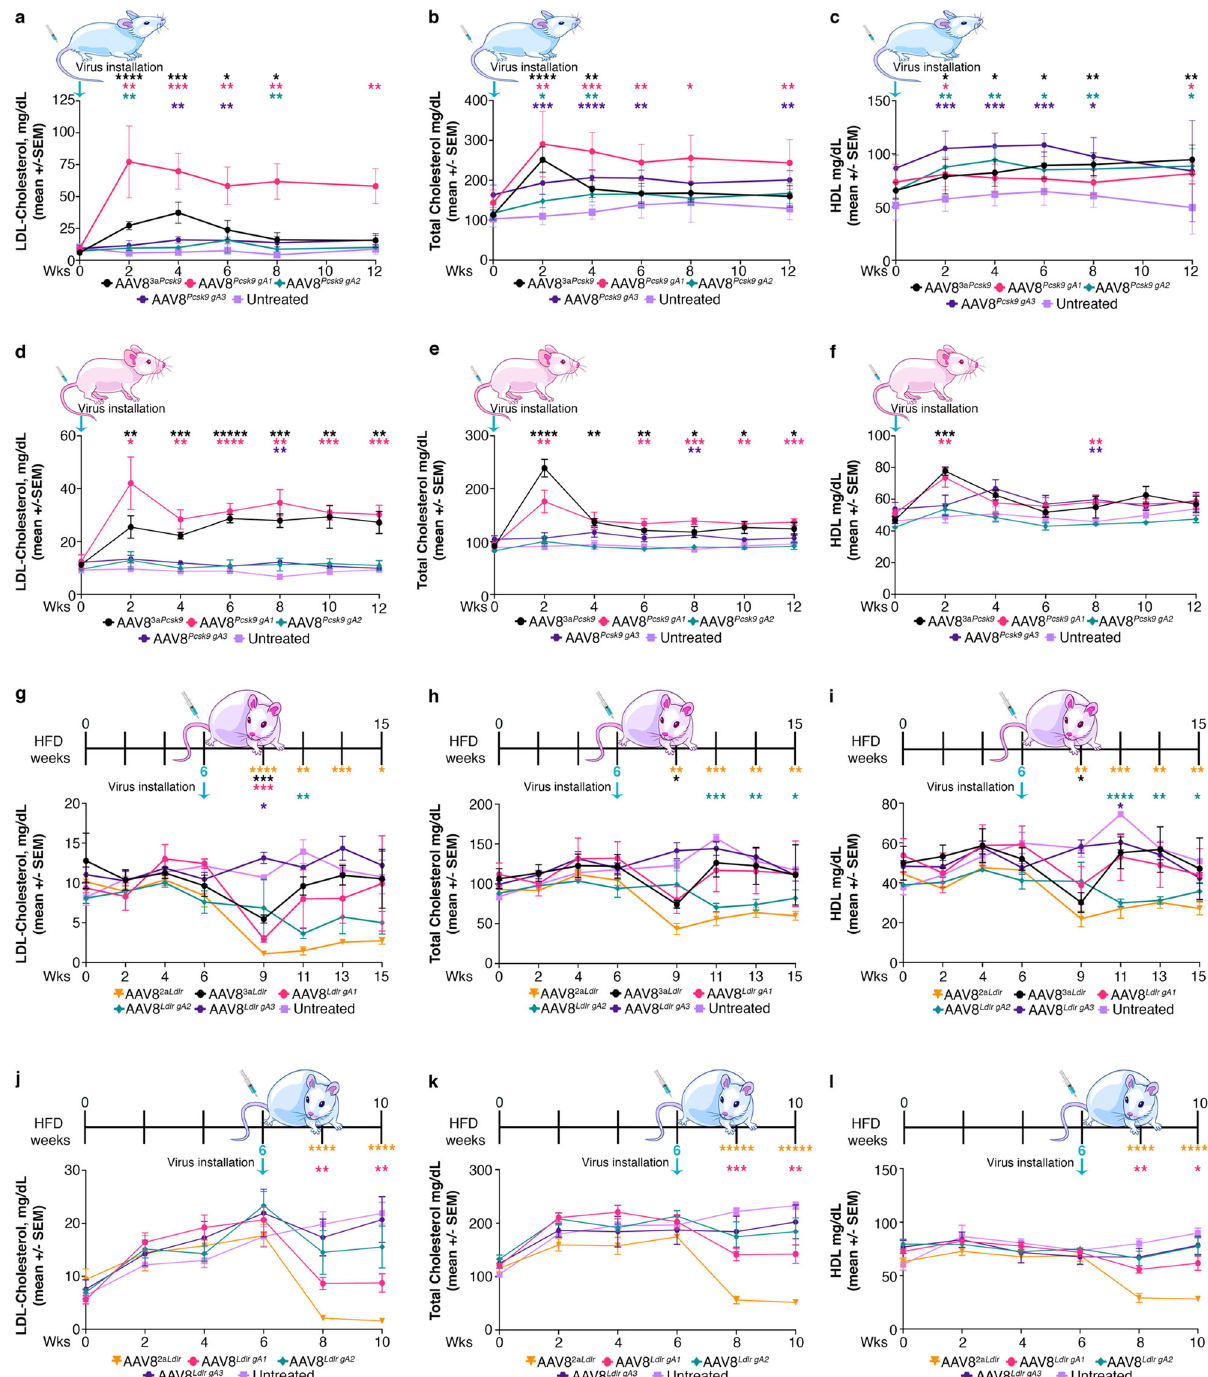
Fig. 5 Bi-directional modulation of lipid metabolism. a – c Pcsk9 activating guides were introduced by AAV8 to male R26 SAM / SAM mice after a baseline bleed ( n = 5) with bi-weekly bleeds taken thereafter for serum chemistry. Weekly p -values can be found in Supplementary Table 5. a LDL-cholesterol, b total cholesterol, and c HDL-cholesterol levels were plotted as mean + / − SEM per group. d – e Pcsk9 activating guides were introduced by AAV8 to female R26 SAM / SAM mice after a baseline bleed ( n = 5) with bi-weekly bleeds taken thereafter for serum chemistry. Weekly p -values can be found in Supplementary Table 5. d LDL-cholesterol, e total cholesterol, and f HDL-cholesterol levels were plotted as mean + / − SEM per group. g – i Homozygous female R26 SAM study mice were placed on a HFD for six weeks prior to AAV8 Ldlr activating viruses were introduced ( n = 4). Weekly p -values can be found in Supplementary Table 5. g LDL-cholesterol, h total cholesterol, and HDL-cholesterol levels were plotted as mean + / − SEM per group. (j-l) Homozygous male R26 SAM study mice were placed on a HFD for 6 weeks prior to AAV8 Ldlr activating viruses being introduced ( n = 5). Weekly p -values can be found in Supplementary Table 5. j LDL-cholesterol, k total cholesterol, and l HDL-cholesterol levels were plotted as mean + / − SEM per group. Statistics: Asterisks (*) indicates signi fi cance, and the number of asterisks indicates the number of 0s after the decimal point. One-tailed, unpaired Student ’ s t -test for ( a – l ).